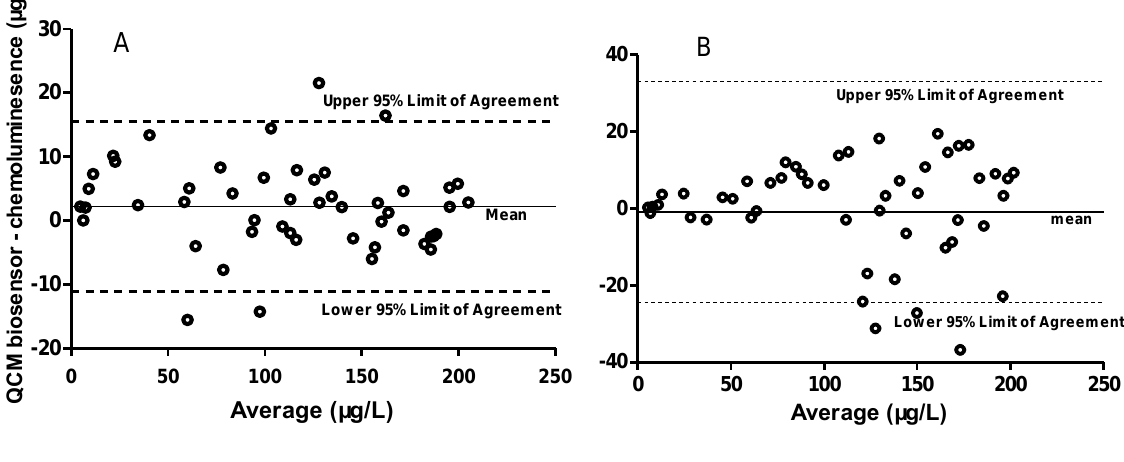
Figure 1. Bland-Altman difference plot for IgE detection results by QCM biosensor and chemoluminesence method. On the horizontal axis, plot the mean of results by the two studied methods. (A) Bland-Altman difference plot comparing IgE detection results obtained with aptamer-based QCM biosensor against Chemoluminesence (Beckman). (B) Bland-Altman difference plot comparing IgE detection results obtained with antibody-based QCM biosensor against Chemoluminesence. The solid line represents the mean difference in quantitative measurement of IgE between the two methods, and the dashed lines are mean ±1.96